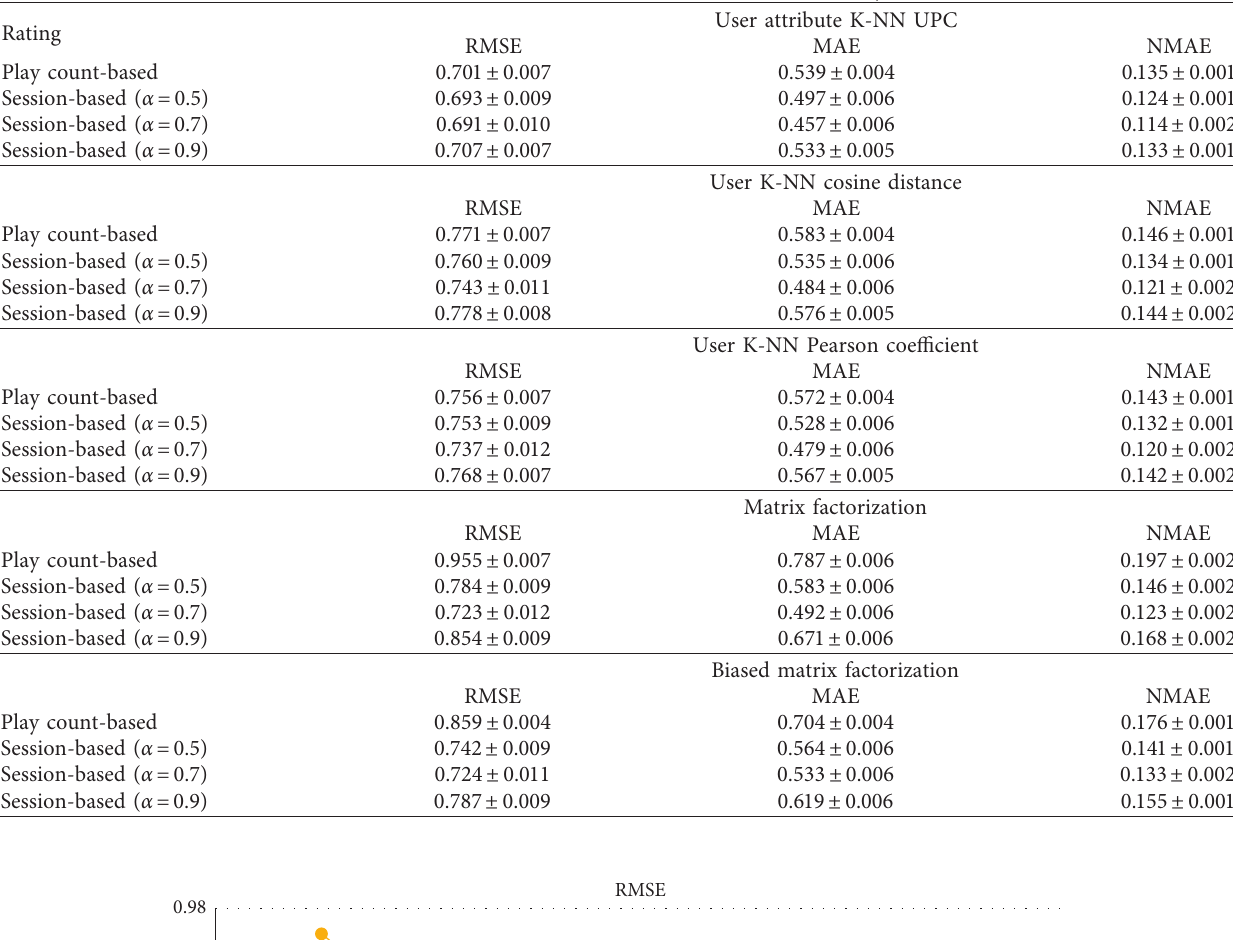
Table 1: Error rates of the methods involved in the study.